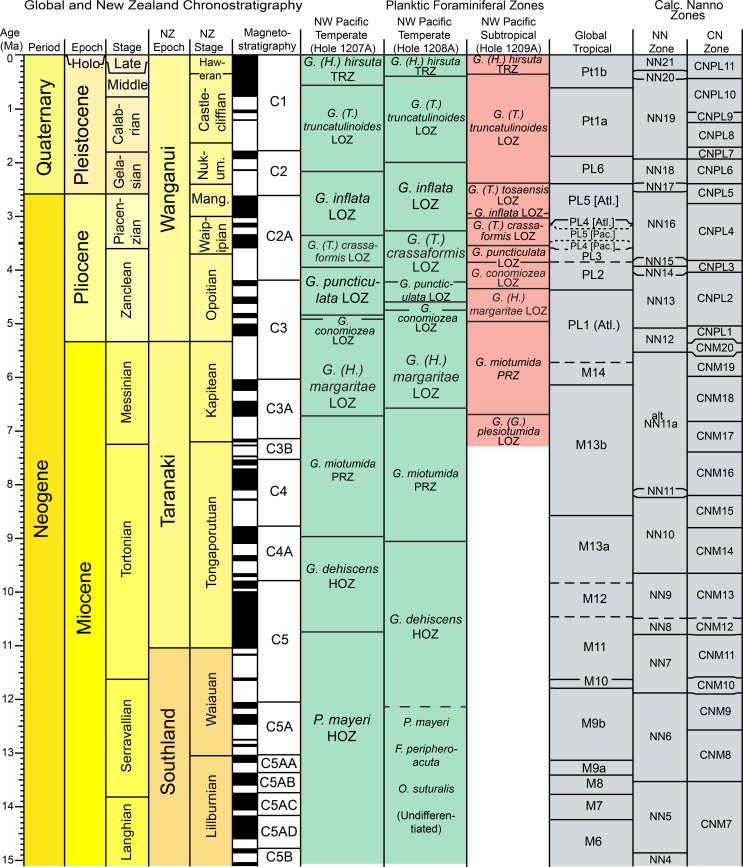
Integrated planktic foraminiferal and calcareous nannofossil biostratigraphic zonation schemes.Global and New Zealand chronostratigraphy, magnetostratigraphy with major chrons and subchrons denoted, the northwest Pacific planktic foraminiferal zones defined in this study from holes 1207A, 1208A, and 1209A, plotted beside the widely-utilized tropical planktic foraminiferal zones [1, 2] and the tropical to mid-latitude calcareous nannofossil zones [98, 99]. Chronostratigraphy, tropical planktic foraminiferal zones, and calcareous nannofossil zones created using TimeScale Creator [62].